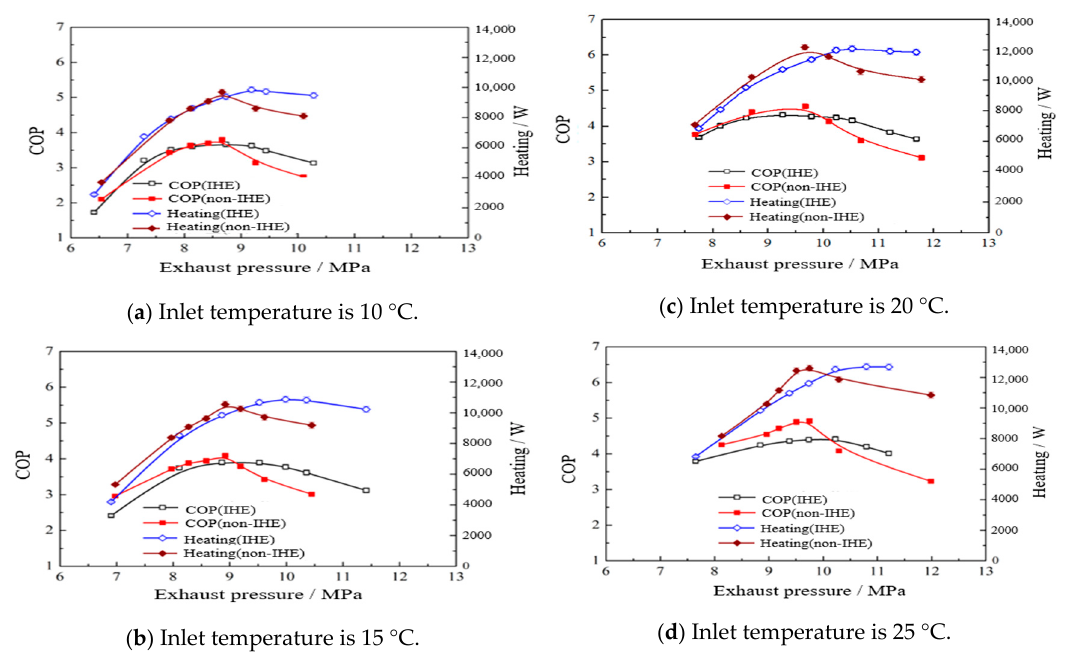
Figure 7. Comparison between heating and COP with and without IHX at different inlet temperatures of water source.